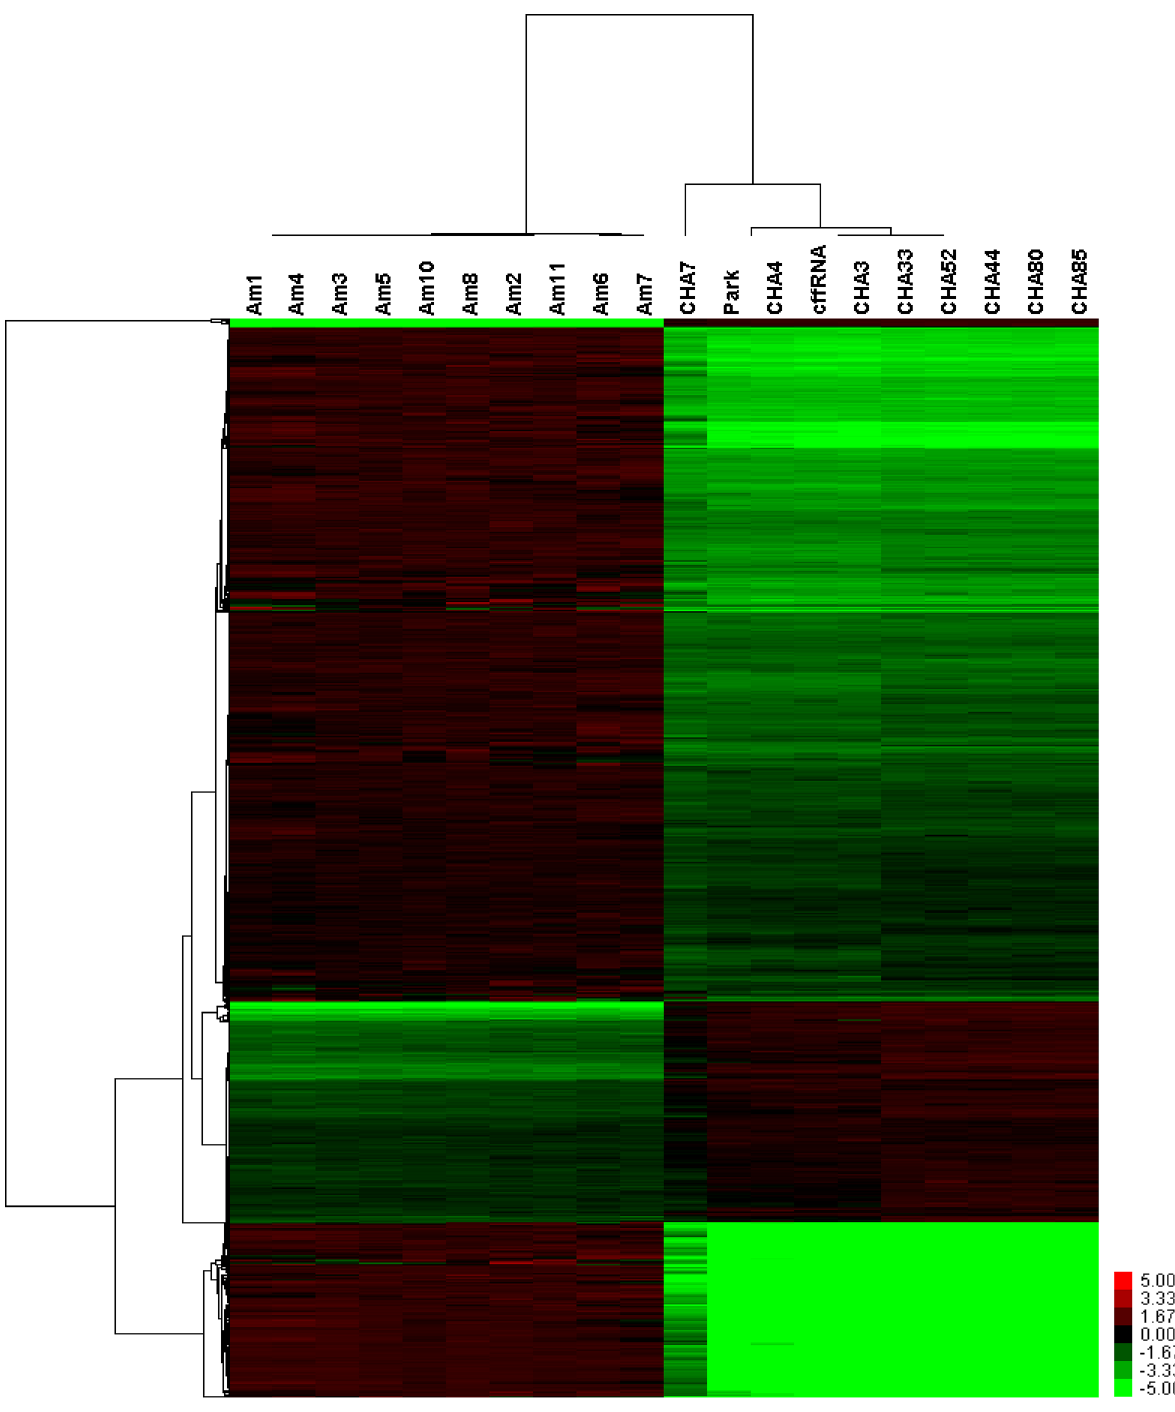
Fig 1. Unsupervised hierarchical clustering analysis for genes differentially expressed between amniocytes and amniotic fluid expression